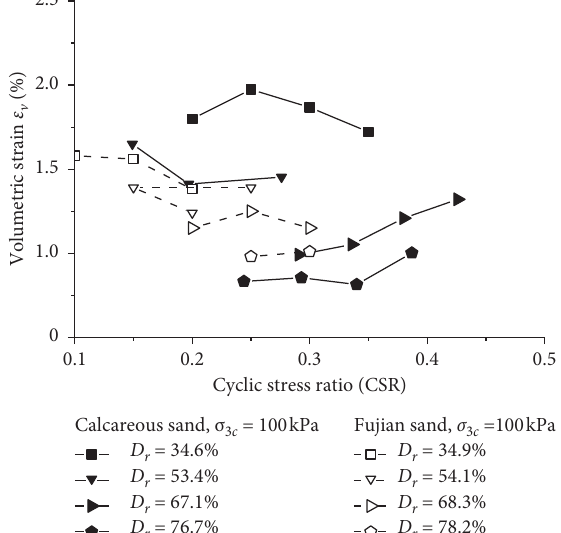
Figure 17: ε V ∼ CSR curve of calcareous sand and Fujian sand.